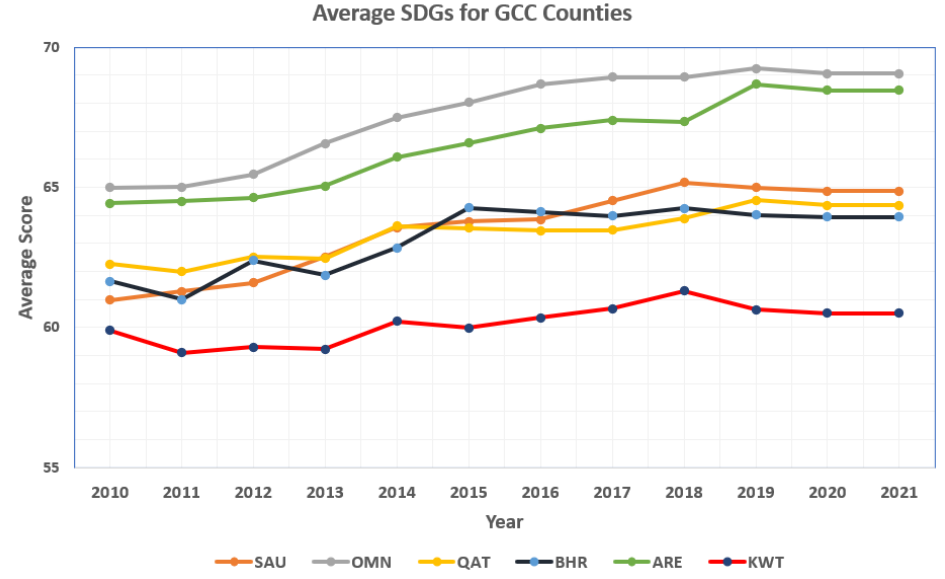
Figure 6. GCC SDG performance until 2021 generated from UN SDR 2021 [35].